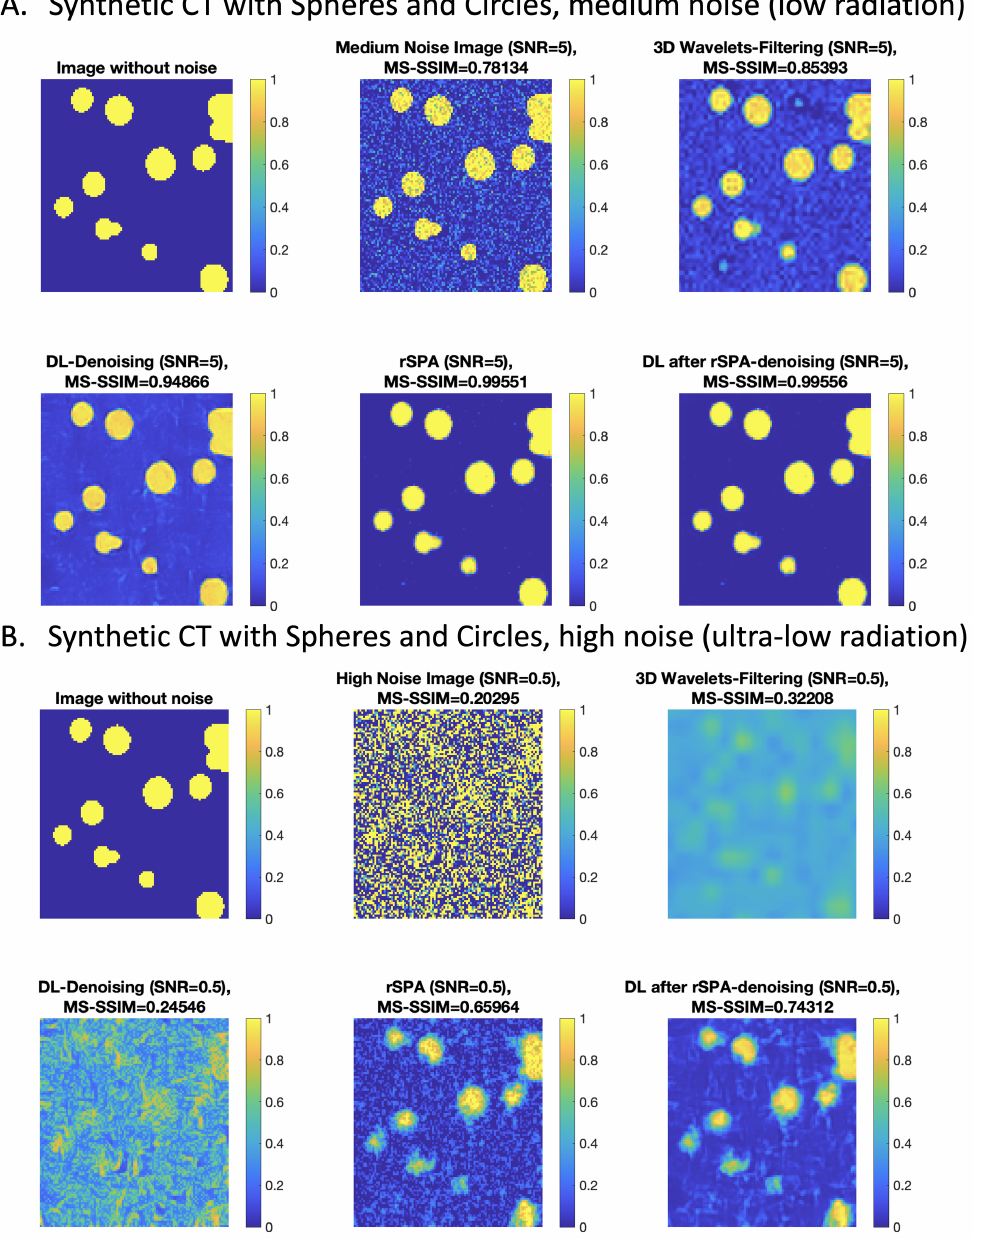
Figure 4. Comparing denoising performance on synthetic CT images of noisy circles, with DL from Figure 3 additionally trained to recognize circles for non-Gaussian noise model: ( A ) medium noise scenario, corresponding to low-radiation regime with around 3.3 mGy; ( B ) high noise scenario, corresponding to ultra-low-radiation regime with 0.5